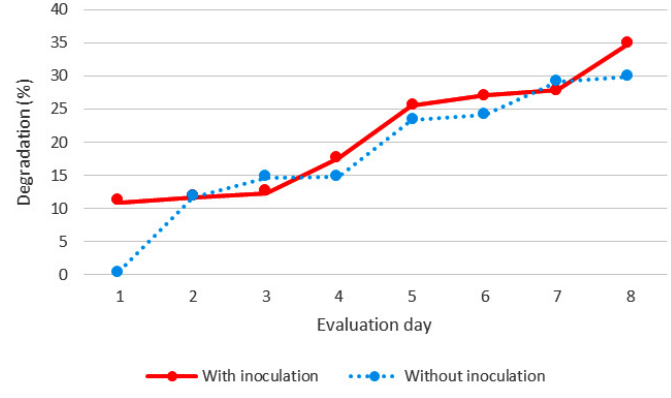
Fig. 3. Carbofuran degradation in presence and absence of bacterial